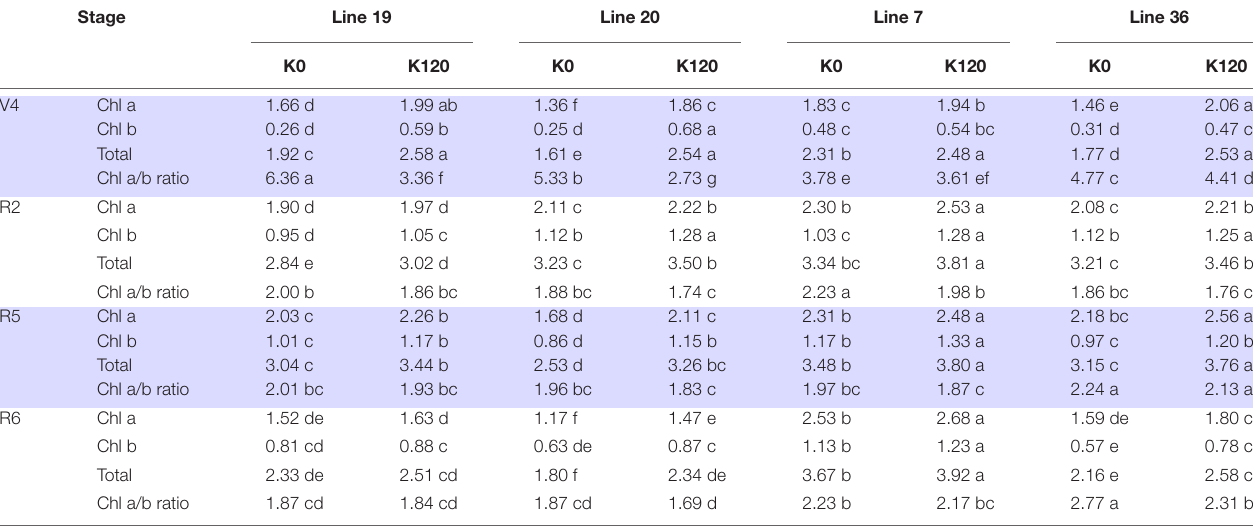
TABLE 4 | Changes of chlorophyll a, chlorophyll b, and total chlorophyll concentrations (mg g − 1 ) of vegetable soybean with different K efficiency in a pot experiment. Stage Line 19 Line